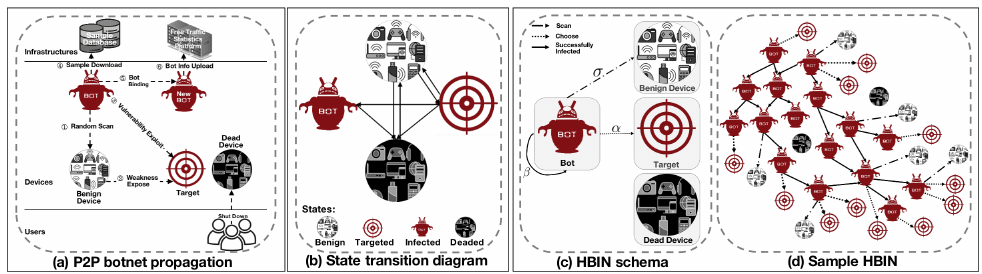
Figure 1. Botnet Infection Model.